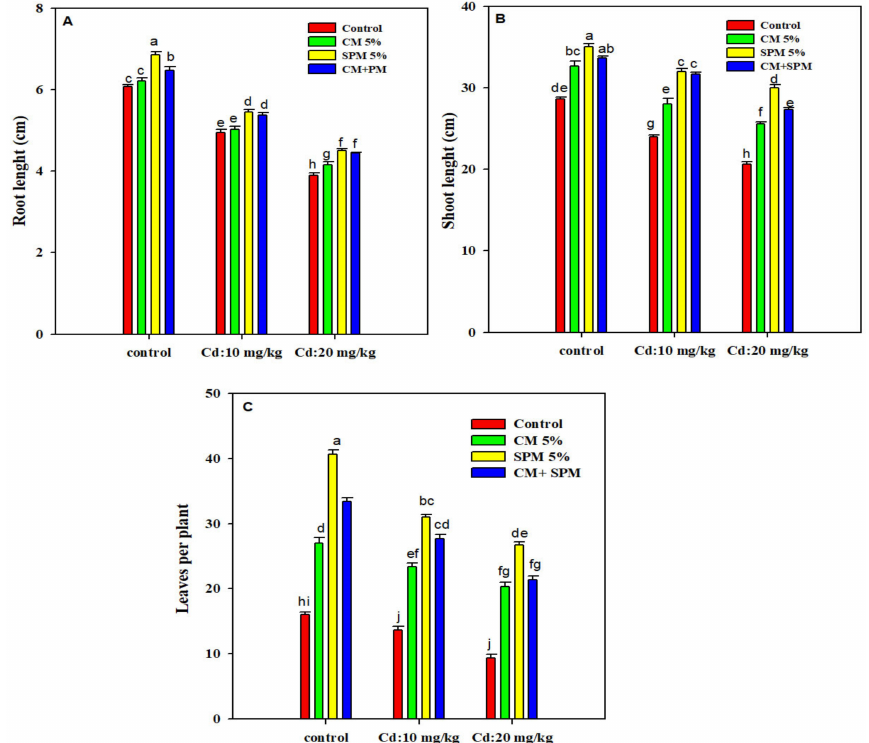
Figure 1. Effect of organic amendments on root length ( A ), shoot length ( B ), and leaves per plant ( C ) of mash bean plants subjected to different levels of Cd stress (0, 10 and 20 mg/kg). The vertical bars in each figure are the mean of three replications with ± S.E. and different letters on bars indicating the significant difference at p <